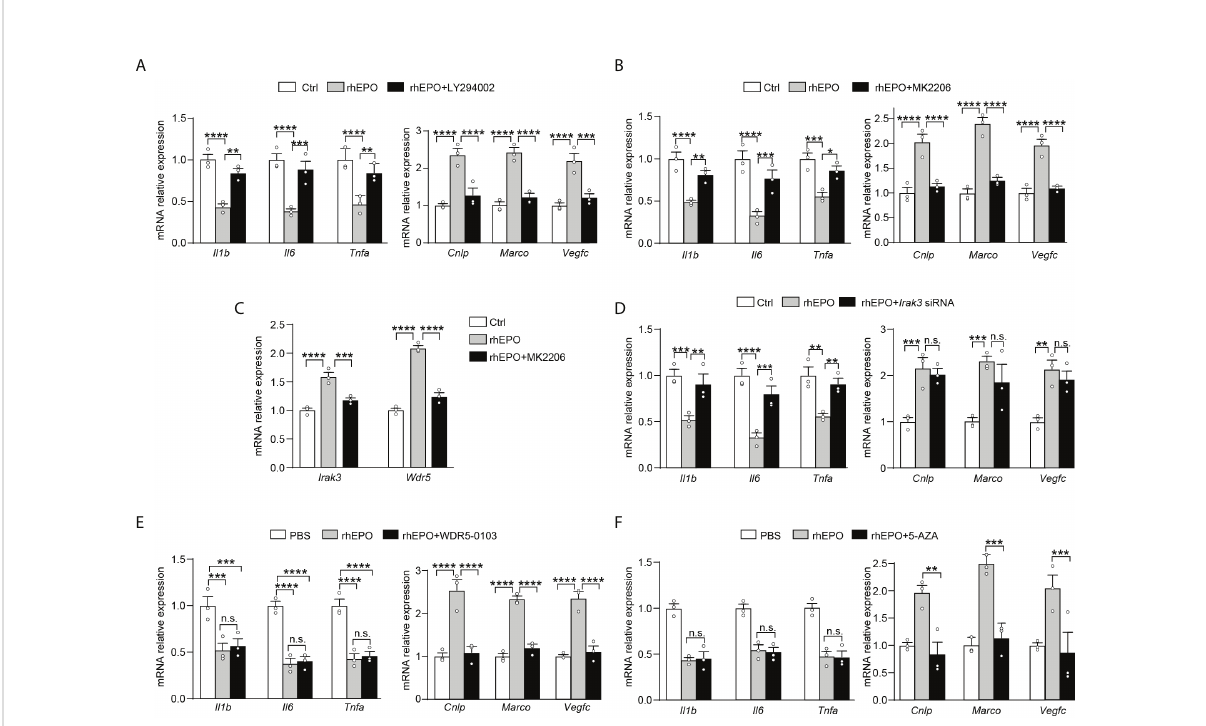
FIGURE 3 EPO mediated re-programming of endotoxin-tolerant macrophages through PI3K/AKT pathway via upregulation of IRAK3 and WDR5 (A, B) : In vitro cultured RAW264.7 macrophages were incubated with PBS, rhEPO (40 IU/ml), and rhEPO (40 IU/ml) + LY294002 (20 m M) (A) or PBS, rhEPO (40 IU/ml), and rhEPO (40 IU/ml) + MK2206 (5 m M) (B) the in presence of LPS (100 ng/ml) for 24 h, and then cells were washed with PBS twice followed by a secondary LPS stimulation (10 ng/ml) for 6 h; gene expression was measured by qRT-PCR (n = 3). (C) : In vitro cultured RAW264.7 macrophages were incubated with PBS, rhEPO (40 IU/ml), or rhEPO (40 IU/ml) + MK2206 (5 m M) in the presence of LPS (100 ng/ml) for 24 h, and then gene expression of Irak3 and Wdr5 was measured by qRT-PCR (n = 3). (D – F) : RAW264.7 macrophages were incubated with PBS, rhEPO (40 IU/ml), and rhEPO (40 IU/ml) + Irak3 siRNA (50 nM) (D) ; PBS, rhEPO (40 IU/ml), and rhEPO (40 IU/ml) + WDR5-0103 (500 nM) (E) ; or PBS, rhEPO (40 IU/ml), and rhEPO (40 IU/ml) + 5-AZA (5 m M) (F) in the presence of LPS (100 ng/ml) for 24 h, and then cells were washed with PBS twice followed by a secondary LPS stimulation (10 ng/ml) for 6 h; gene expression was measured by qRT-PCR (n = 3). Data are representative of three independent experiments. Results were expressed as means ± SEM. *P < 0.05, **P < 0.01, ***P < 0.001, and ****P < 0.0001. n.s., not statistically signi fi cant. Statistics: two-way ANOVA with Tukey ’ s post-hoc test for multiple comparisons. "n.s." stands for "not statistically signi fi cant “